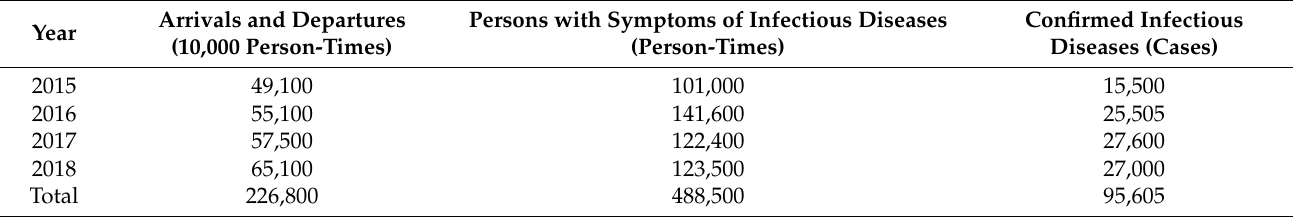
Table 1. Health Quarantine at Border of China